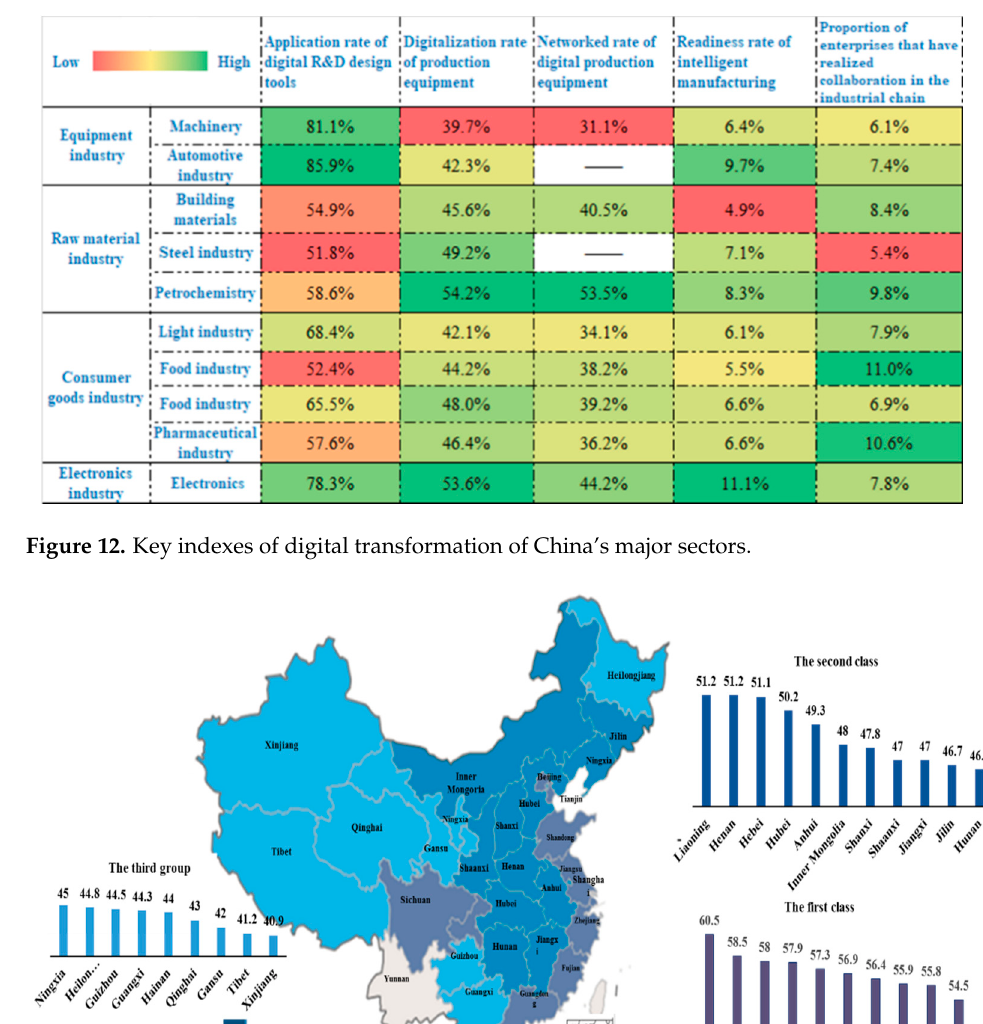
Figure 12. Key indexes of digital transformation of China’s major sectors.